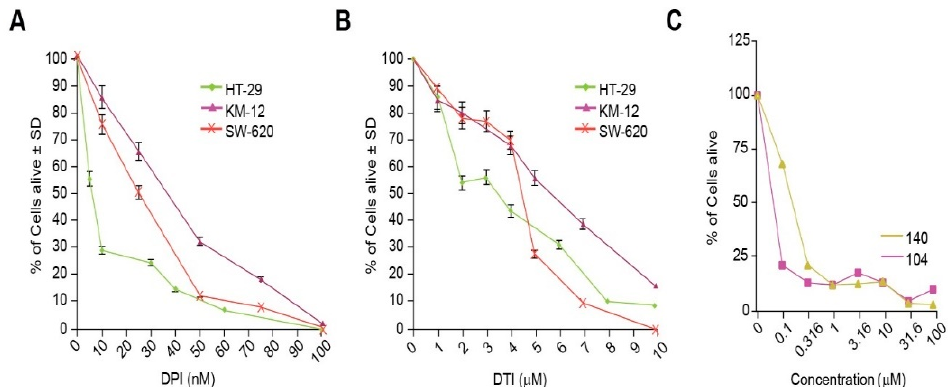
Figure 3. Inhibition of tumor cell growth by iodonium analogs. The effect of DPI and DTI on the proliferation of HT-29, KM-12, and SW620 colon cancer cells is shown in ( A , B ). Panel ( C ) demonstrates the concentration-dependent effects of NSC 751140 and NSC 740104 on the growth of HT-29 human colon cancer cells; mean data representative of triplicate experiments are shown. The effects of the two DPI analogs were not assessed in KM-12 and SW-620 cells because of their lack of NOX1 expression. In some cases, the error bars are too small to be observed ( C ).